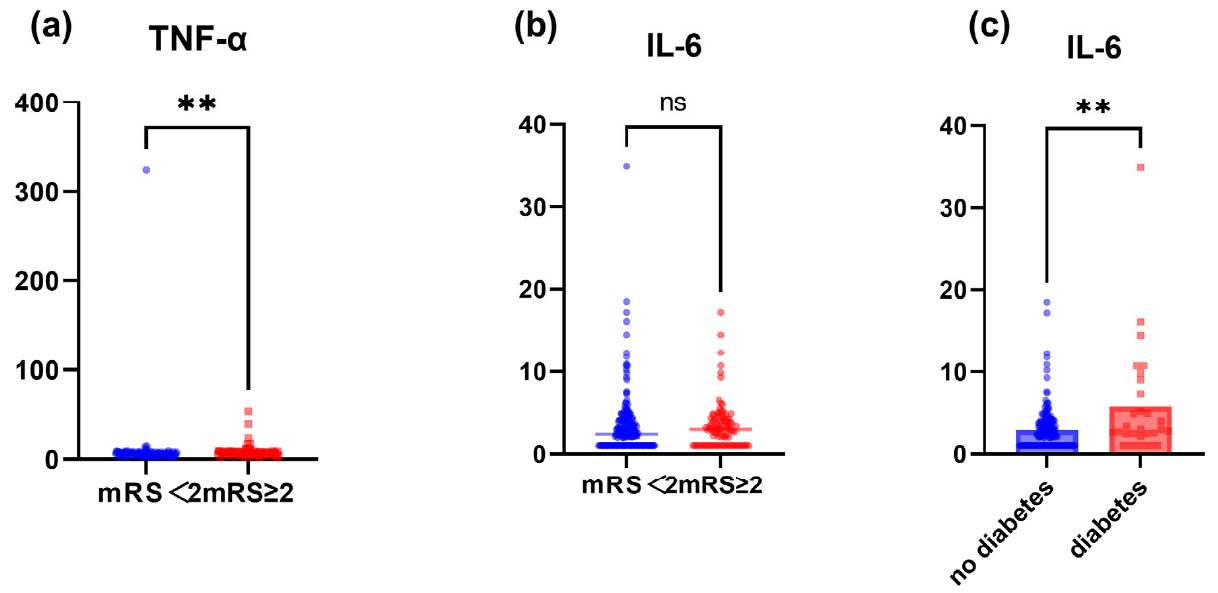
Figure 1. Comparison of serum TNF- α and IL-6 concentrations. ( a ) Differences in TNF- α between mRS < 2 and mRS ≥ 2 groups. ( b ) Differences in IL-6 between mRS < 2 and mRS ≥ 2 groups. ( c ) Differences in IL-6 between diabetes and no diabetes groups. ns, no significance; ** p < 0.01. 3.2. Higher TNF- α and IL-6 Levels in the p.R4810K Variant of RNF213